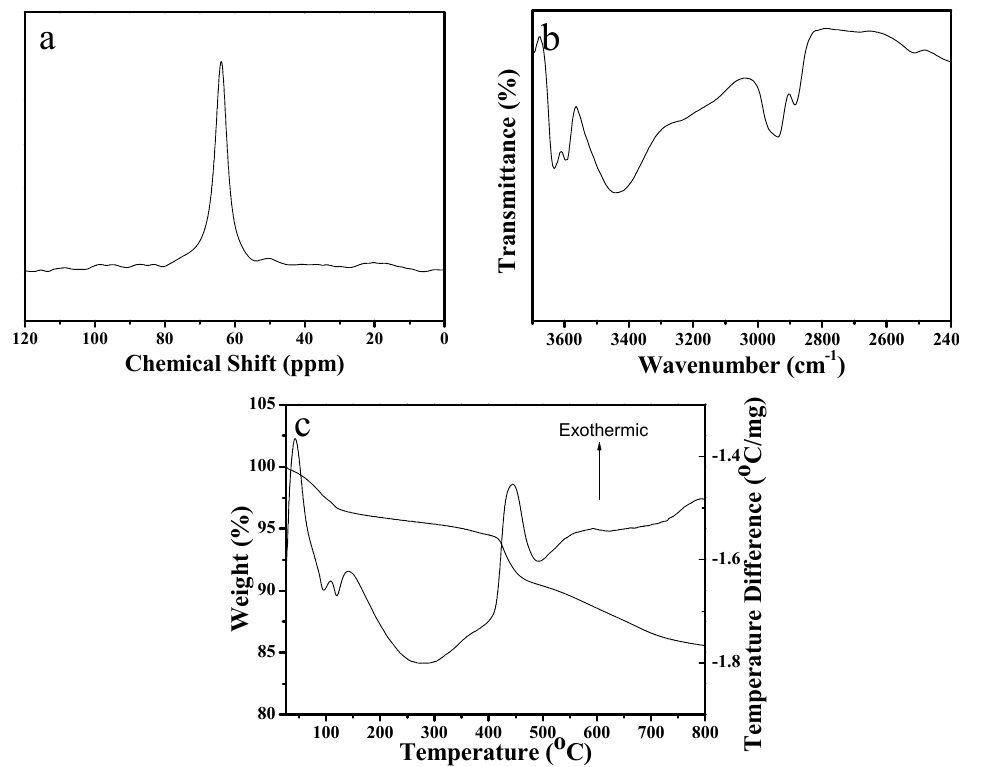
Figure 4. ( a ) 13 C MAS NMR spectrum, ( b ) IR spectrum, and ( c ) TG-DTA curves of the as-made S–Si–SOD zeolite synthesized at 200 ° C.